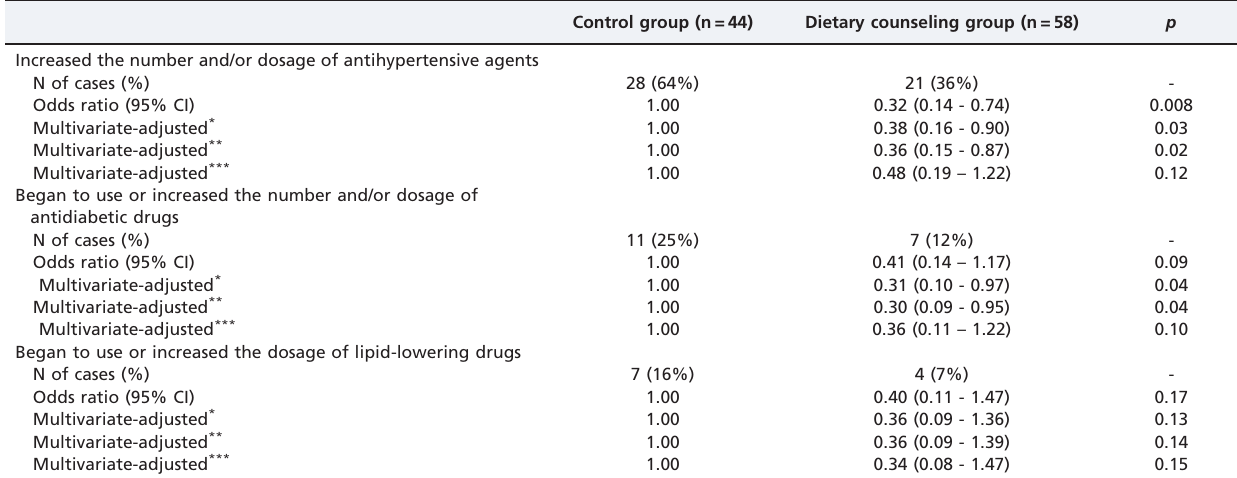
Table 3 - Odds ratios (95% CIs) for the changes in the use of antihypertensive, antidiabetic, and lipid-lowering drugs during the study period according to dietary